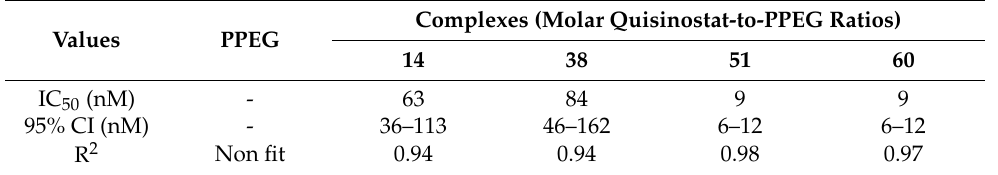
Table A1. IC 50 values of quisinostat–PPEG complexes in A549 NSCLC cells (72 h): IC 50 values calculated on the basis of complex or polymer concentrations.